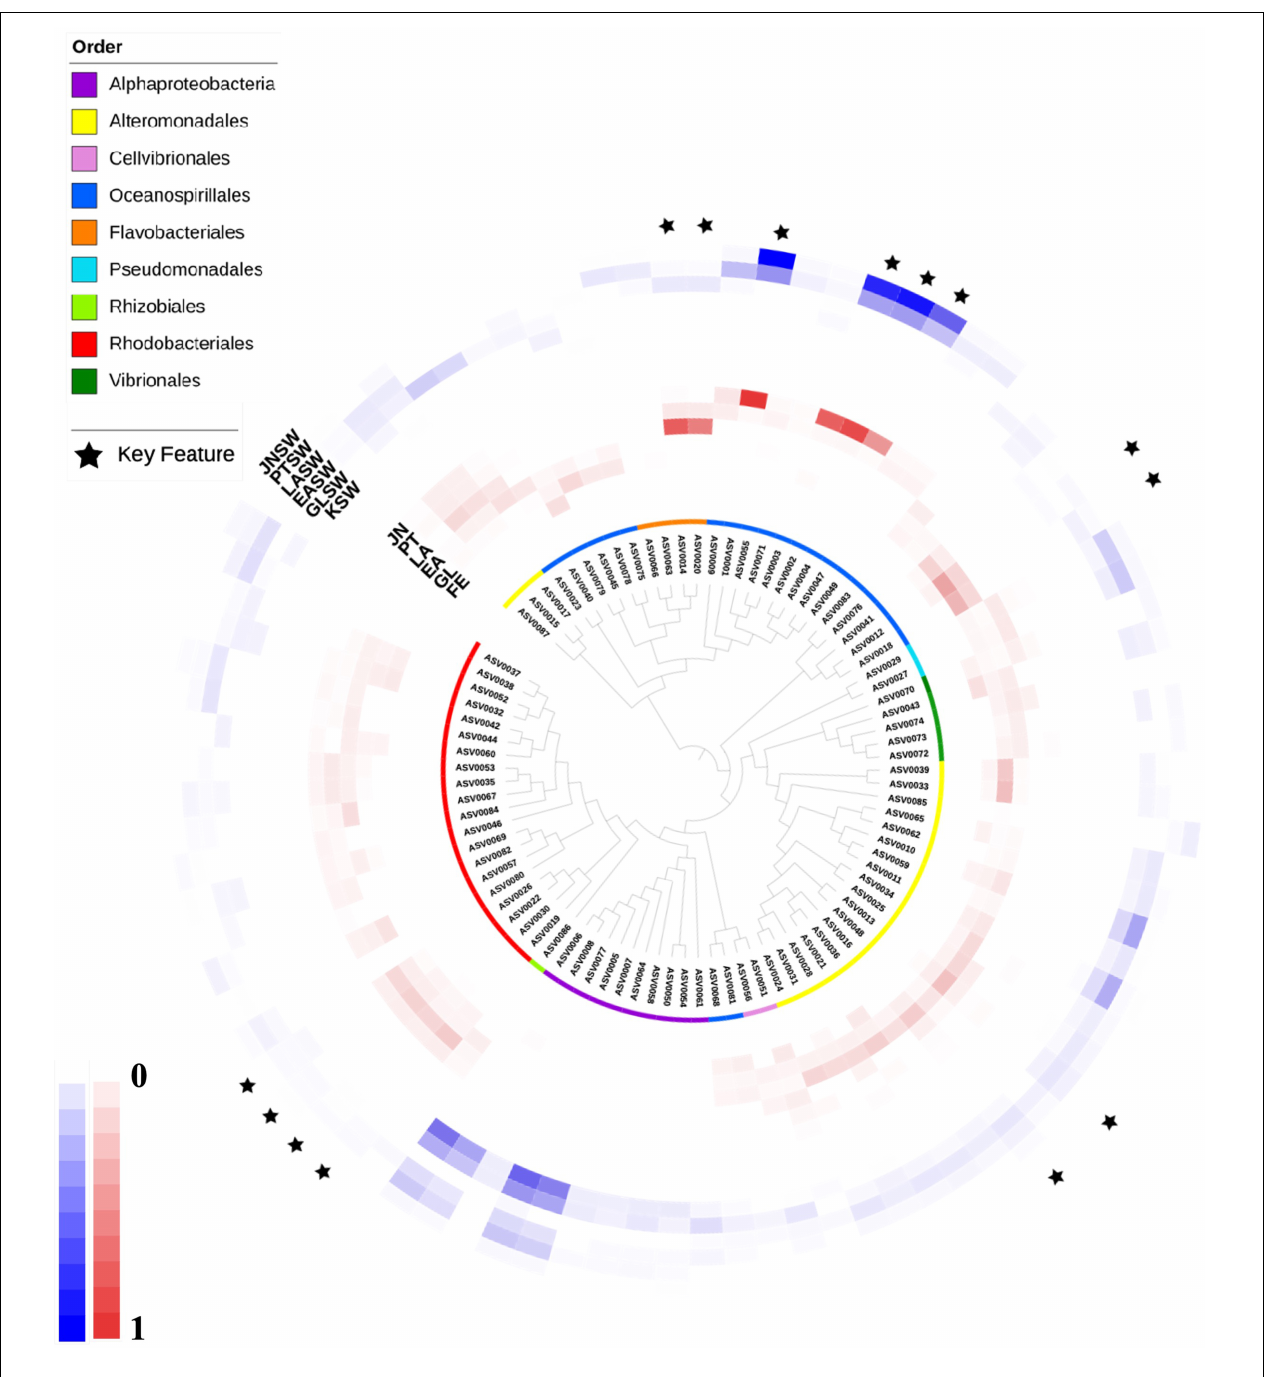
FIGURE 6 | A phylogenetic tree based on features having > 500 reads with relative abundance. Inner circles represent taxonomic analysis at order lever. Red colored heatmap represent relative abundance of features in sea cucumber samples. Blue colored heatmap showed relative abundance of features in seawater samples. Key features were labeled with black stars. FE, Fertilized egg; GL, Gastrula; EA, Early auricularia; LA, Late auricularia; PT, Pentactula; JN, Juvenile; FESW, Fertilized egg rearing seawater; GLSW, Gastrula rearing seawater; EASW, Early auricularia rearing seawater; LASW, Late auricularia rearing seawater; PTSW, Pentactula rearing seawater; JNSW, Juvenile rearing